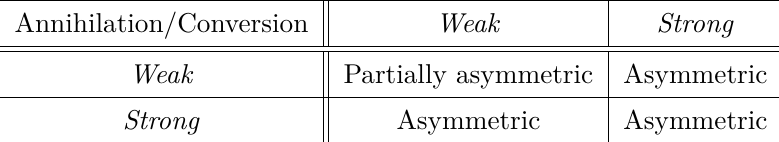
Table 1 . Behavior of multi-component DM (except for the lightest component), depending on interaction strength. ‘Asymmetric’ denotes that the DM is completely asymmetric.